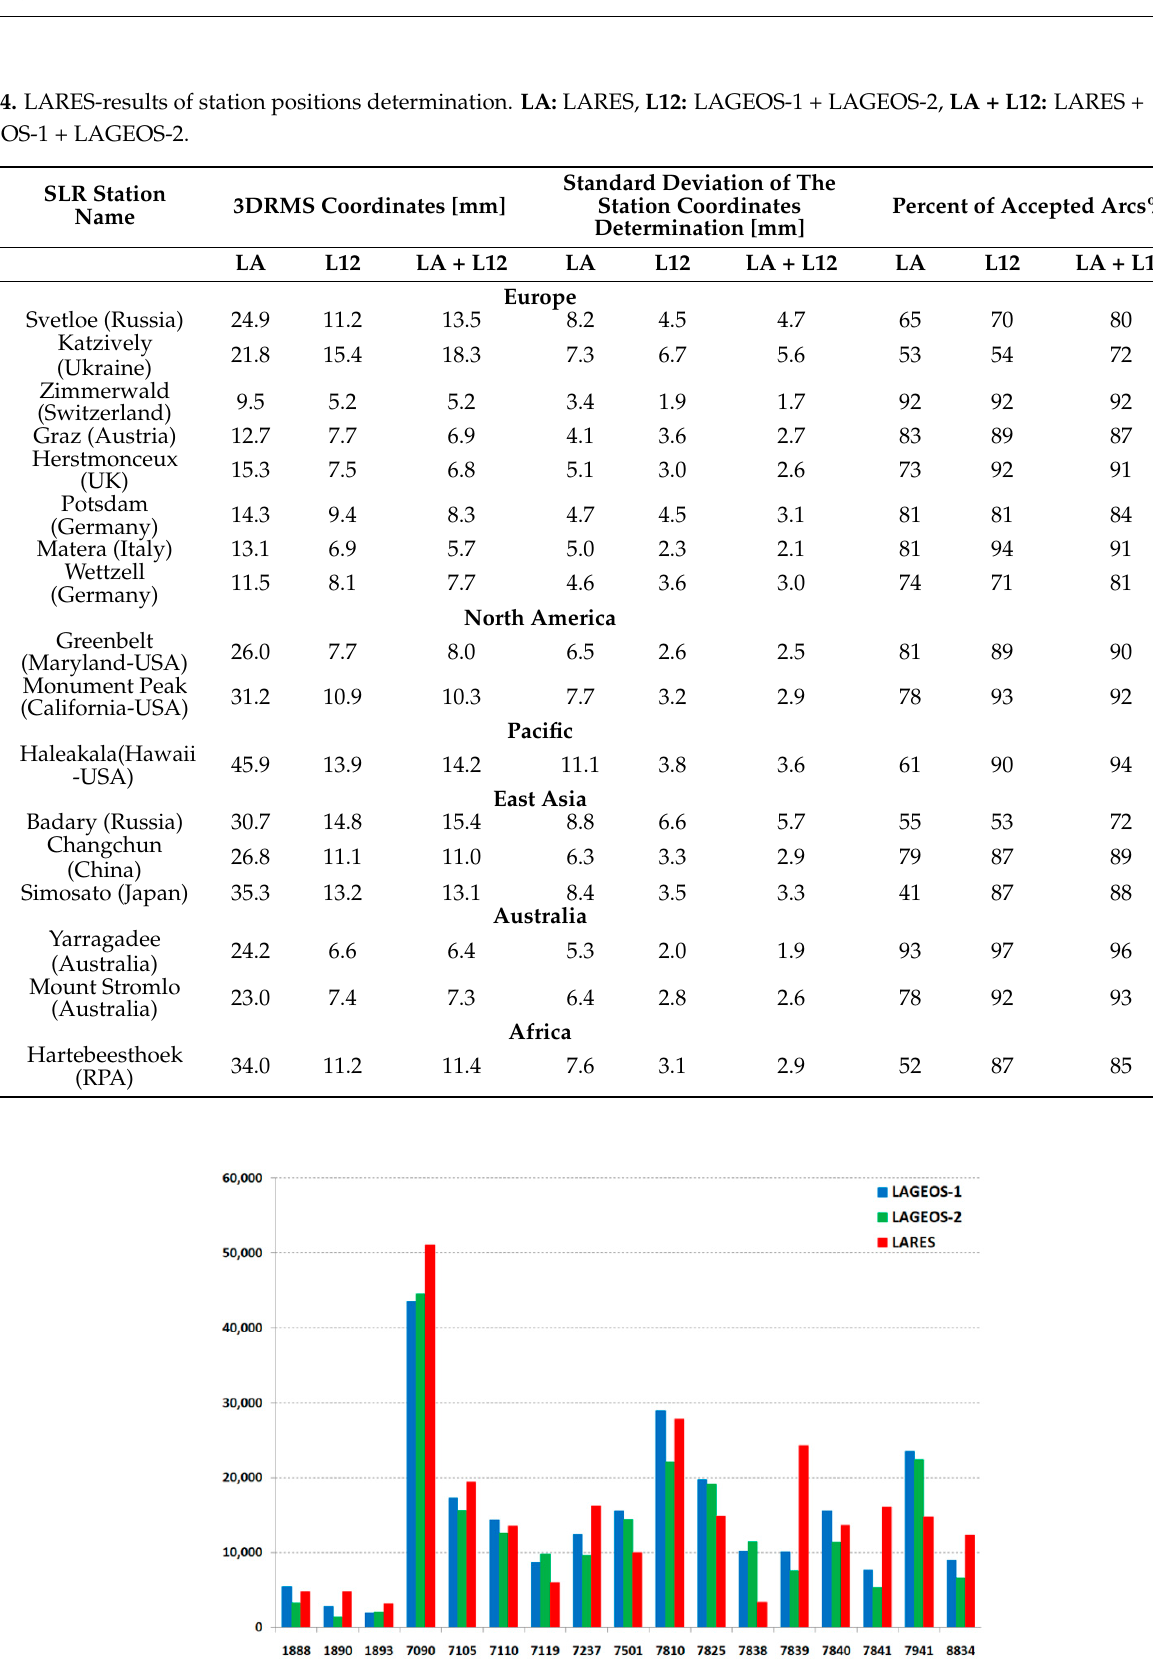
Figure 2. The number of normal points per station in the period from 29 February 2012 to 31 De- cember 2015.